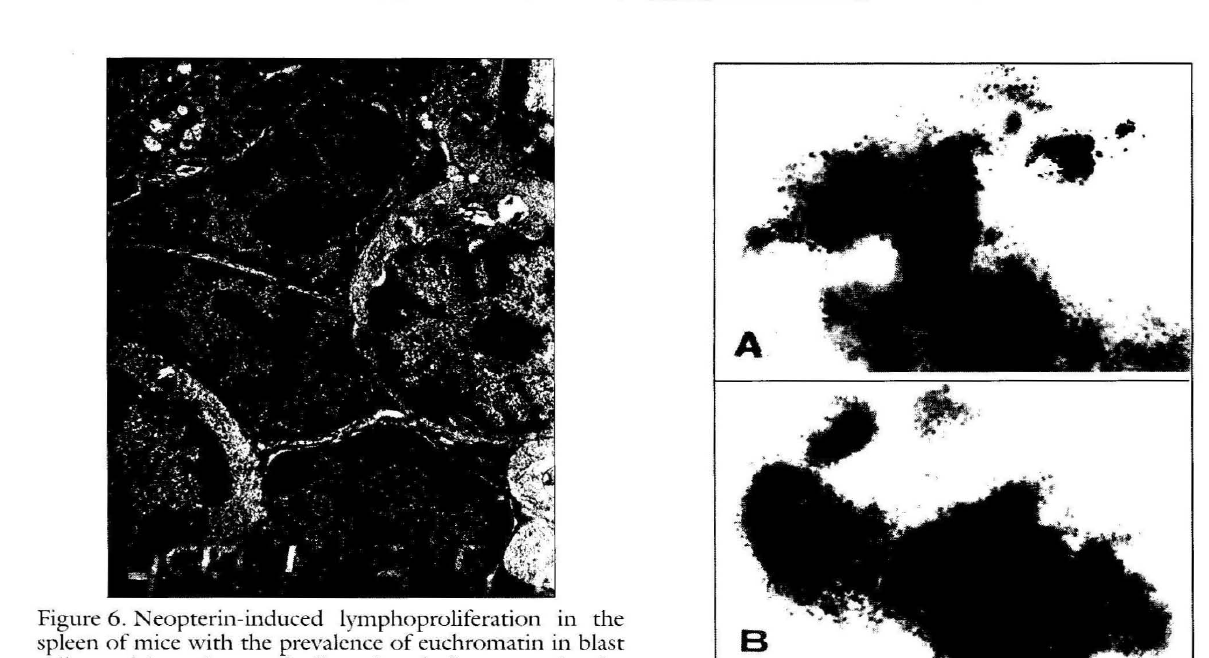
Figure 6. Neopterin-induced lymphoproliferation in the spleen of mice with the prevalence of euchromatin in blast cells nuclei, active nucleoli and polyribosomes in the cytoplasms (Opton electron microscope; x65,OOO).